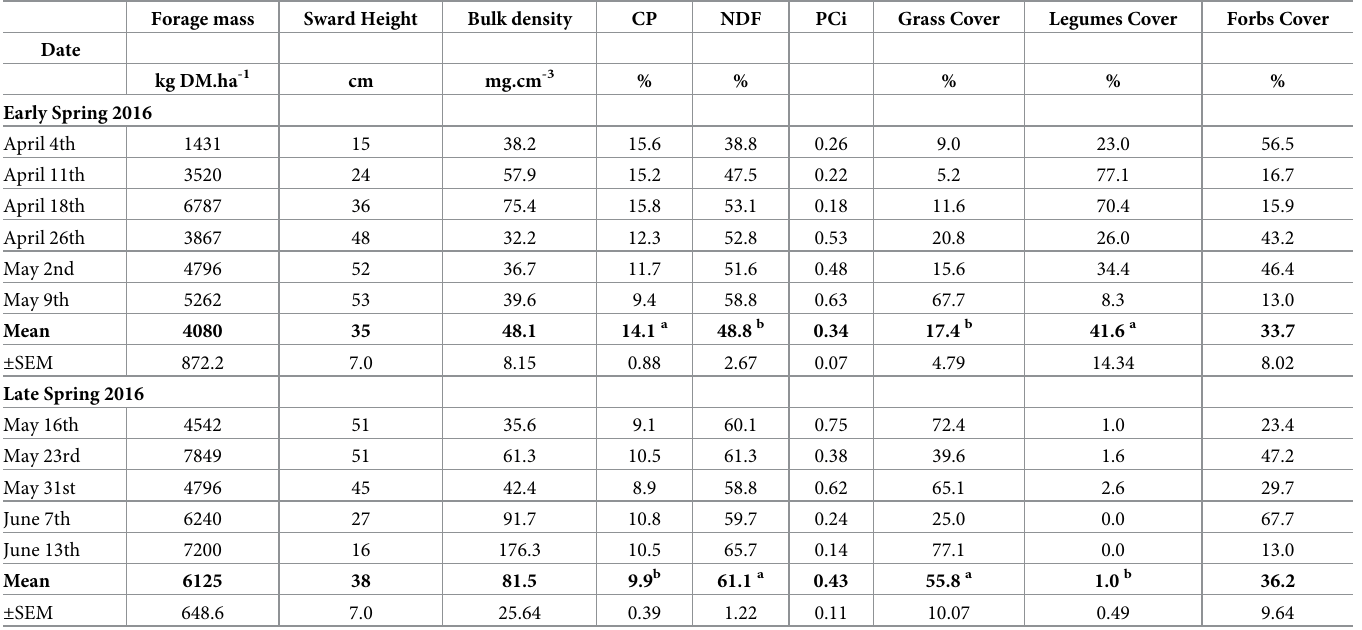
Table 1. Weekly variation in sward characteristics (structure, nutritive value and composition) of patches selected for grazing. Forage mass